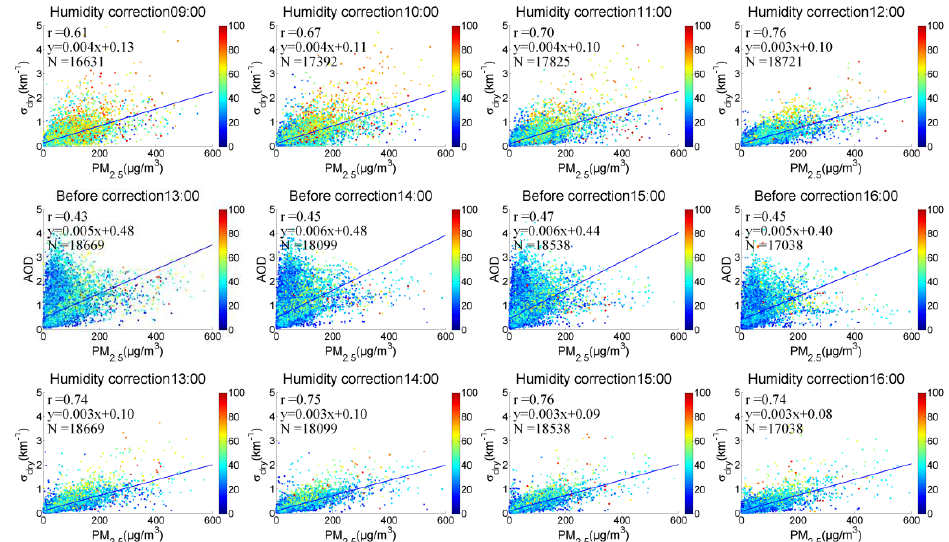
Figure 6. Scatterplots of both AOD with PM 2.5 and σ dry with PM 2.5 for different hours (09:00–16:00 local times) in Hebei (colorbar represents RH).